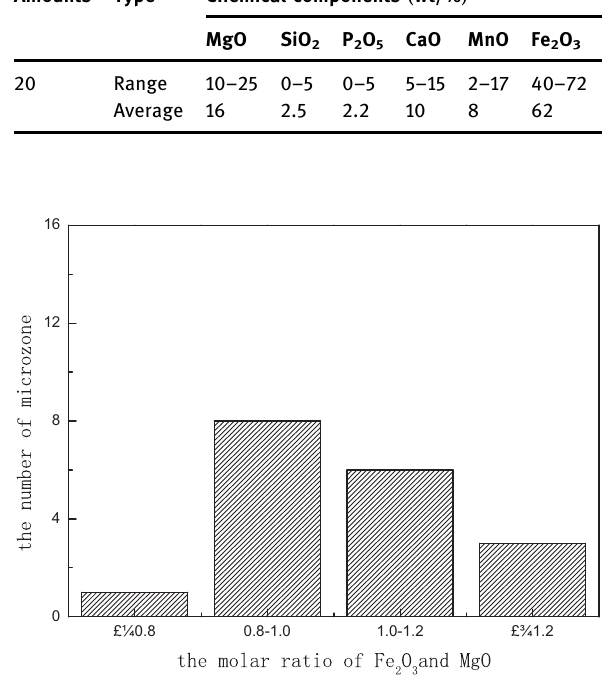
Figure 11: The molar ratio of Fe 2 O 3 to MgO in phase D.